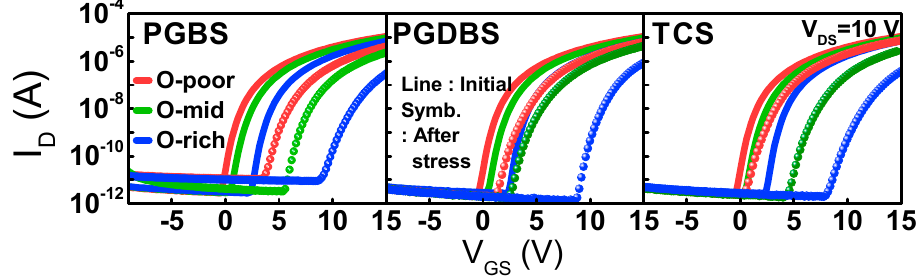
Figure 4. Transfer V GS –I DS characteristics at V DS = 10 (V) over a range of O-content as stress time under PGBS, PGDBS, and TCS. Lines denote the initial state, and symbols indicate values after each stress condition.